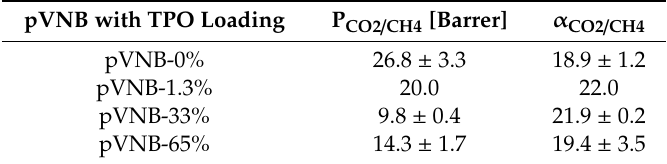
Table 6. Mixed-gas properties of pVNB crosslinked with different TPO loadings.